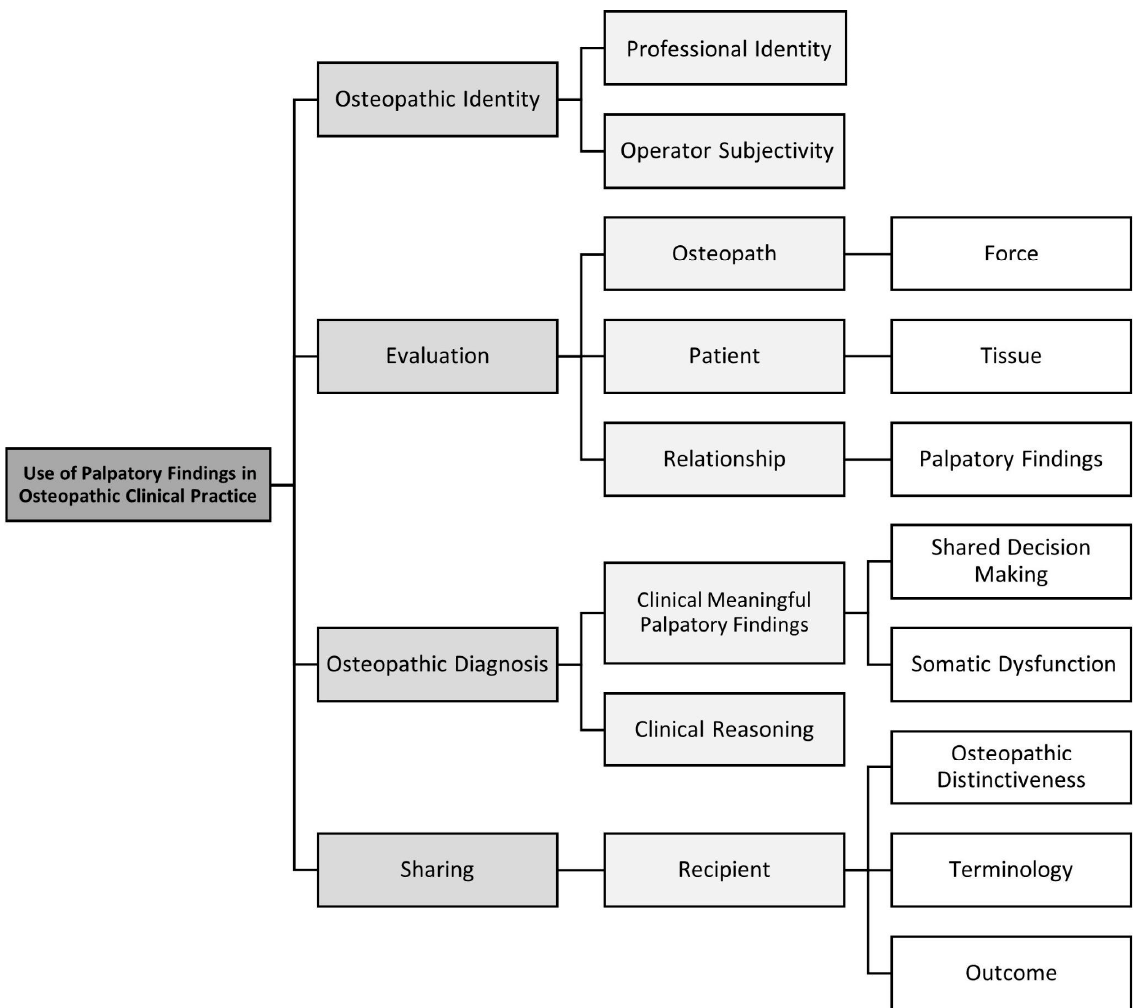
Figure 4. Use of palpatory findings in osteopathic clinical practice.